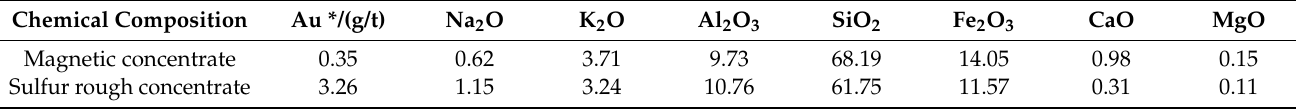
Table 12. Chemical compositions of coarse magnetic and sulfur concentrates (mass fraction, %).